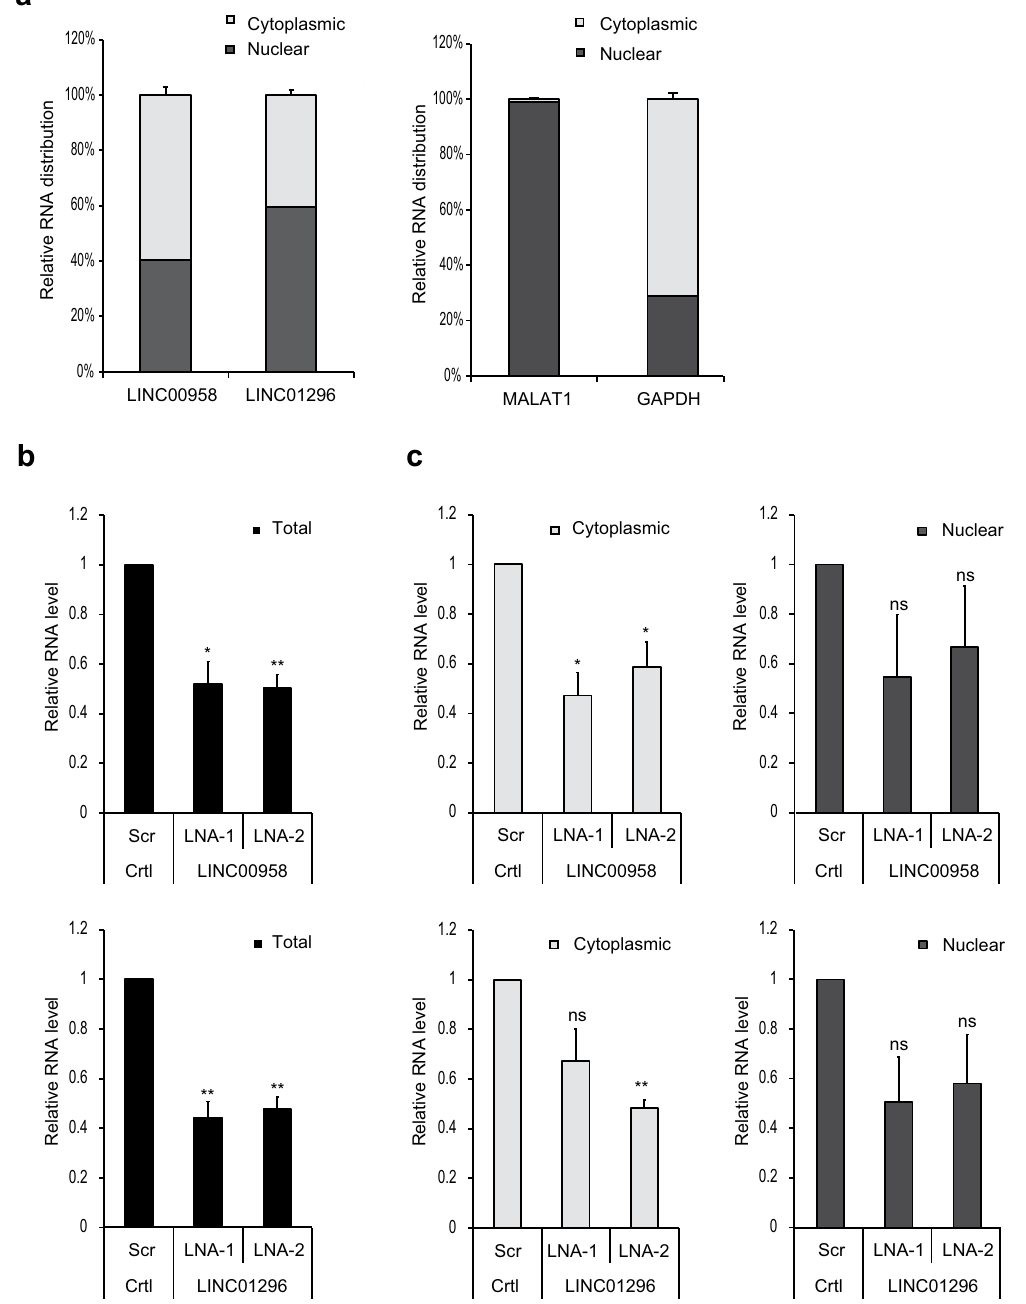
Figure 2. Subcellular distribution and knock-down efficiency of LINC00958 and LINC01296 in FL3 cells. ( a ) Percentage of total RNA found in the nuclear and cytoplasmic fraction in FL3 cells determined by RT- qPCR. Left panel: lincRNA-candidates. Right panel: nuclear (MALAT1) and cytoplasmic (GAPDH) markers for fraction purity. ( b and c ) FL3 cells were transfected with the indicated LNA longRNA GapmeR (50 nM) followed by total ( b ) or fractionated ( c ) RNA extraction 48 hours post-transfection. Knock-down-efficiency of lncRNA-candidates was analyzed by RT-qPCR. Relative total RNA expression levels were normalized to GAPDH and compared to Scr. Relative subcellular RNA expression levels were normalized to Scr. Columns represent the average of two independent experiment measured in triplicates. Bars: standard deviation (SD), ns: not significant and * p < 0.05 and ** p <